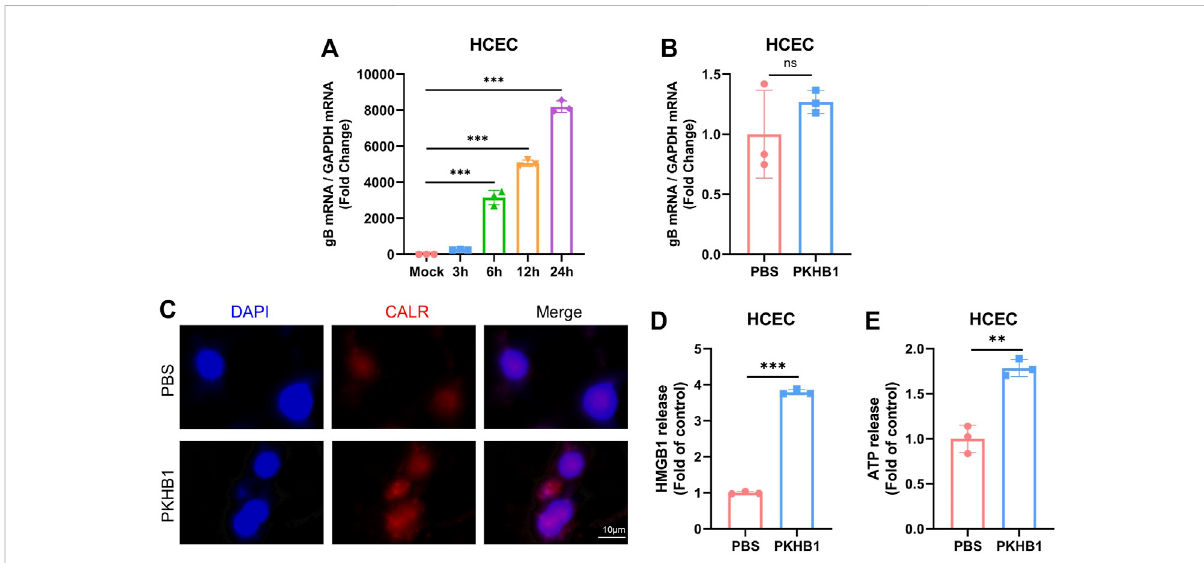
FIGURE 6 PKHB1 peptide may enhance the local immuneresponse by promoting the occurrence of ICD in infected cells. (A) HSK in vitro infection model in HCECs. (B) Infected HCECs were treated with PBS or PKHB1 peptide and the expression levels of HSV-1 gB were measured using qRT-PCR. GAPDH was used as an internal reference. PKHB1 peptide did not directly inhibit HSV-1 replication, but increased the release of more immunostimulatory factors from infected cells. (C) CALR exposure was observed by microscopy in HCECs using CALR staining and DAPI.